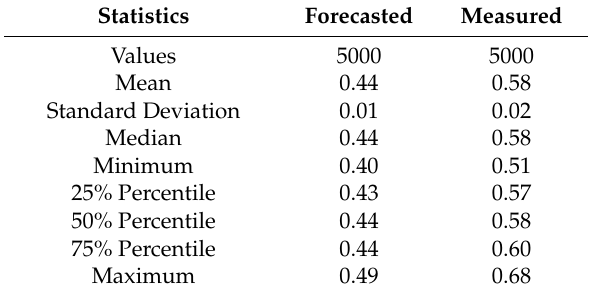
Table 4. Descriptive statistics of the total cost of energy production ( €